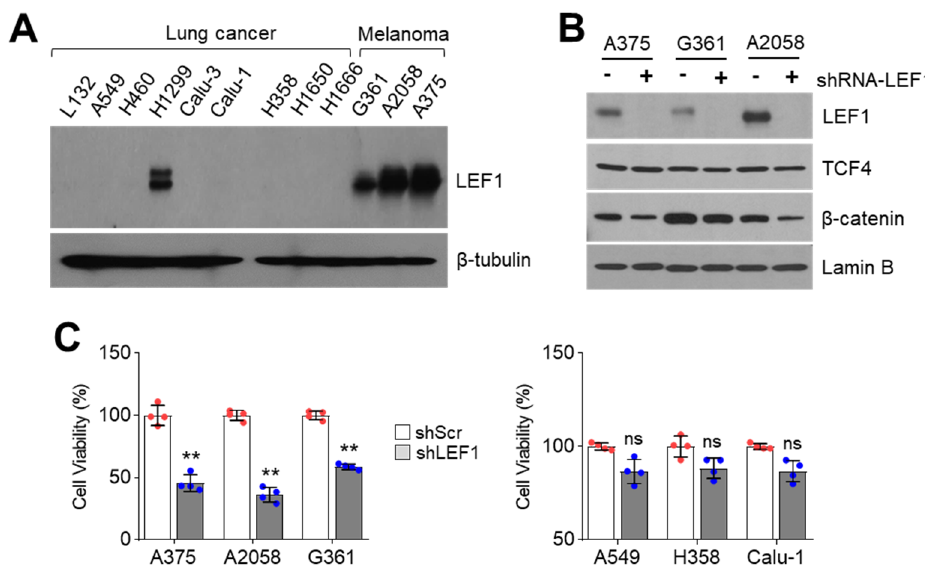
Figure 1. Suppression of LEF1 attenuates melanoma cell growth. ( A ) LEF1 expression in lung cancer and melanoma cell lines. LEF1 protein levels were measured by using Western blotting. ( B ) LEF1 knock-down efficiency in melanoma cell lines. A375, A2058, and G361 melanoma cell lines were infected with lentivirus expressing shRNA against control or LEF1. The infected cells were selected by puromycin for six days. − , shRNA-scramble and + , shRNA-LEF1. ( C ) LEF1 knock-down attenuates melanoma cell growth but not lung cancer cells. LEF1 knocked-down melanoma and lung cancer cells were generated and cell viability was measured by crystal violet staining. The values represent the mean ± SD ( n = 4); ns, not significant and ** p < 0.01. Red and blue points, mean value of individual sample.